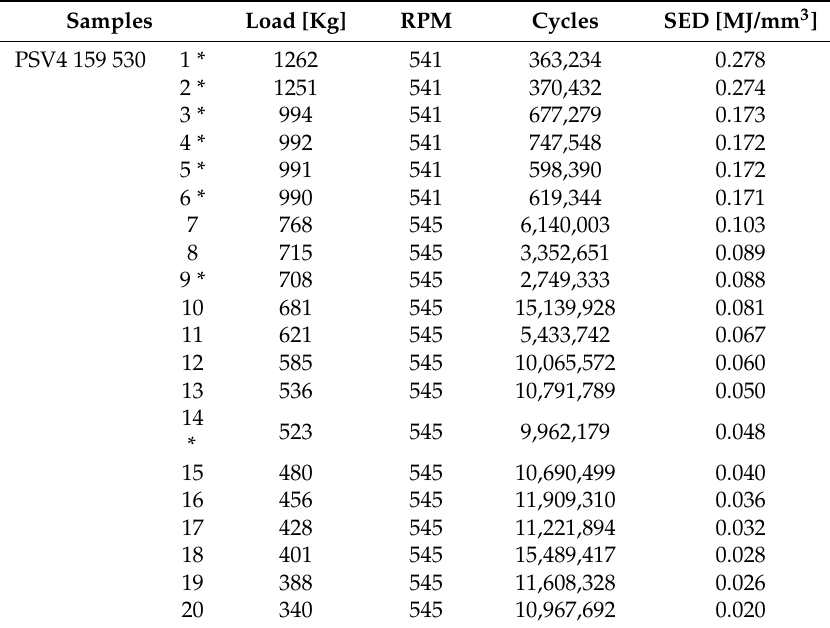
Table 6. Fatigue data for the roller PSV4 159